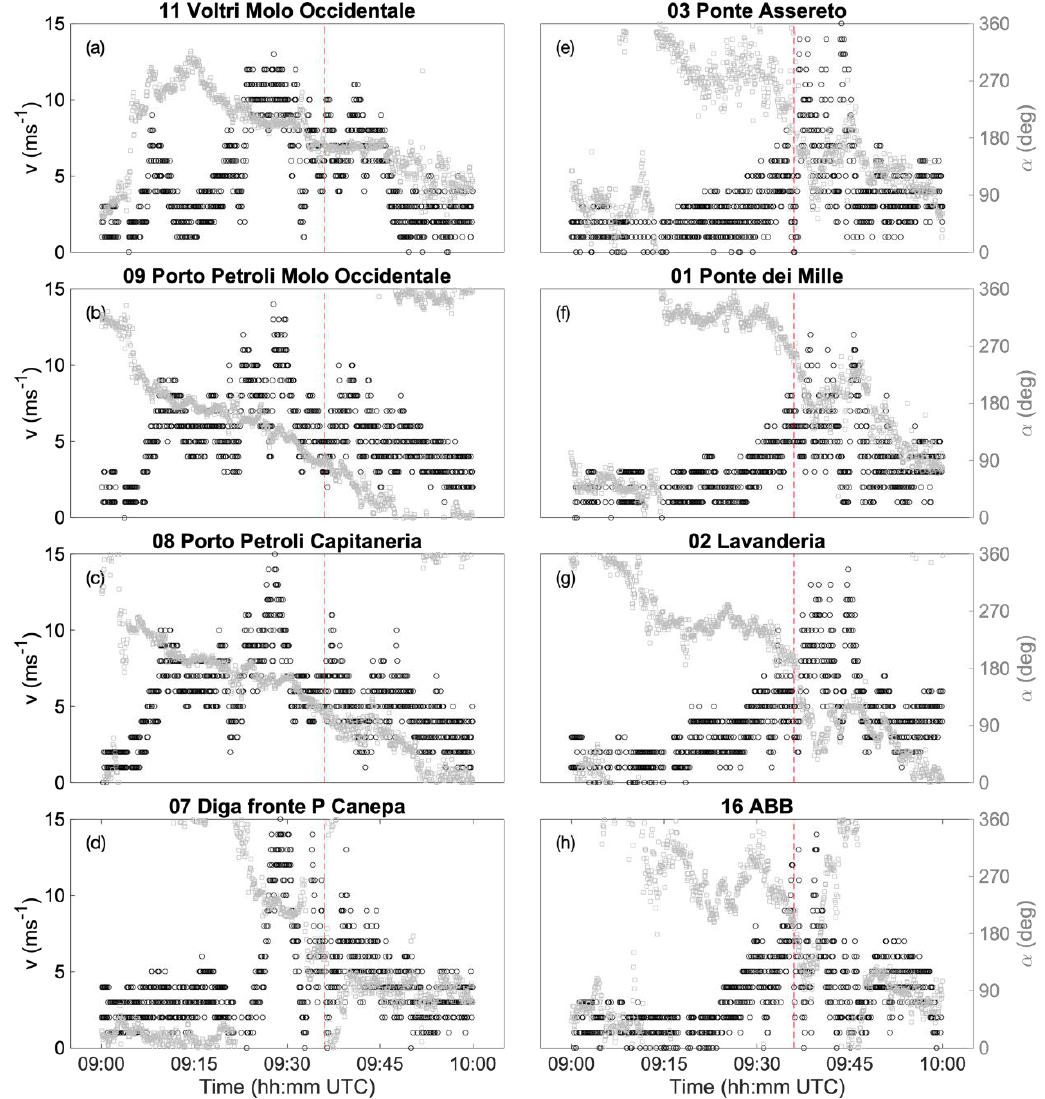
Figure 11. Wind speed (black dots; primary 𝒚 -axis) and wind direction (grey dots; secondary 𝒚 -axis) from 8 anemometers in the Port of Genoa. The vertical red (dotted) lines indicate the bridge collapse time. Panels ( a )–( d ) represent the stations west and south from the Morandi Bridge, while panels ( e )–( h ) are the stations southeast from the bridge (see Figure 2 for details).